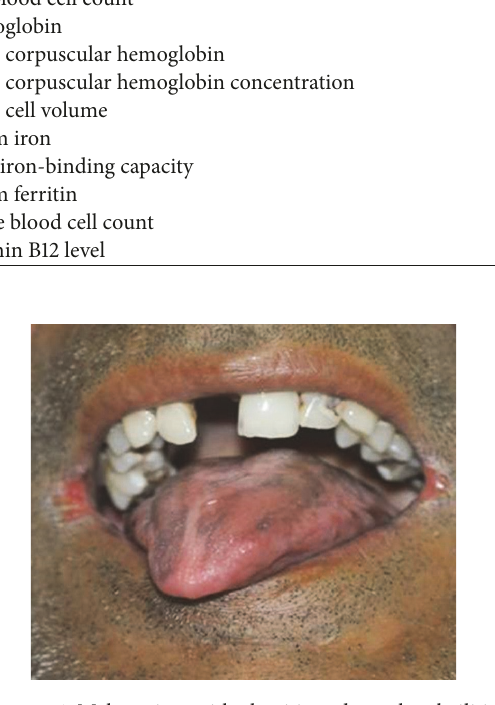
Figure 1: Male patient with glossitis and angular cheilitis.